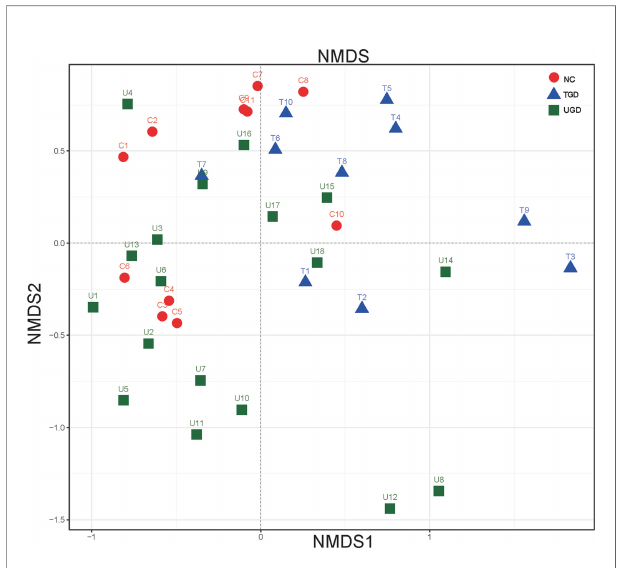
FIGURE 4 | Two-dimensional sorting diagram of samples analyzed by unweighted UniFrac NMDS among the three groups. Each point represents a sample, and points of different colors belong to different groups.